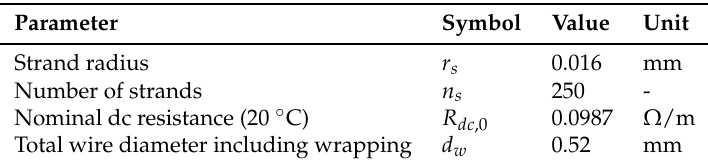
Table 1. Litz wire